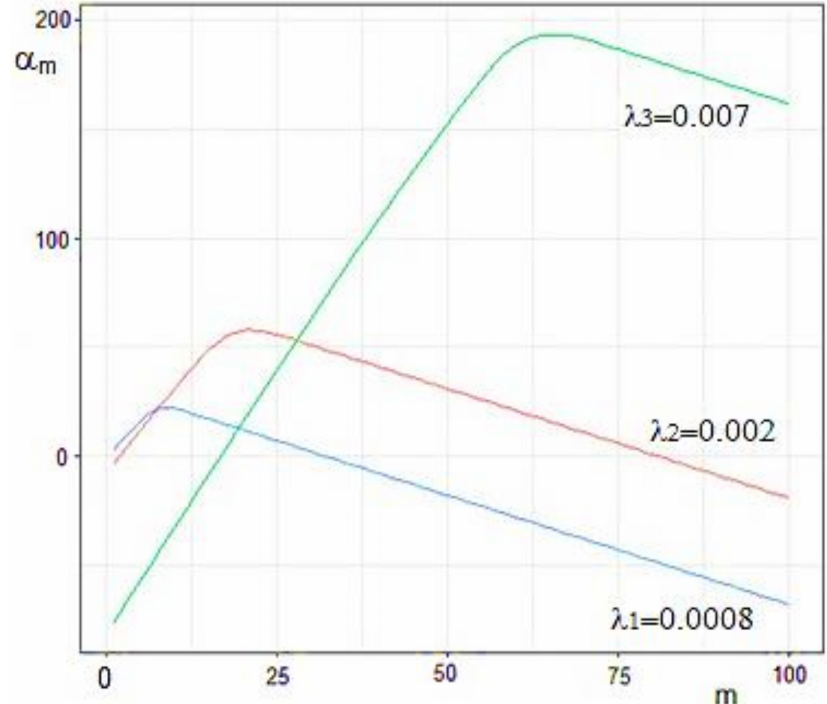
Figure 6. Simulation of average gains α m for various numbers of vehicles m for the following data: λ 1 = 0.0008, λ 2 = 0.002, and λ 3 = 0.007 and µ = 0.009. The OY axis represents Average Profit.